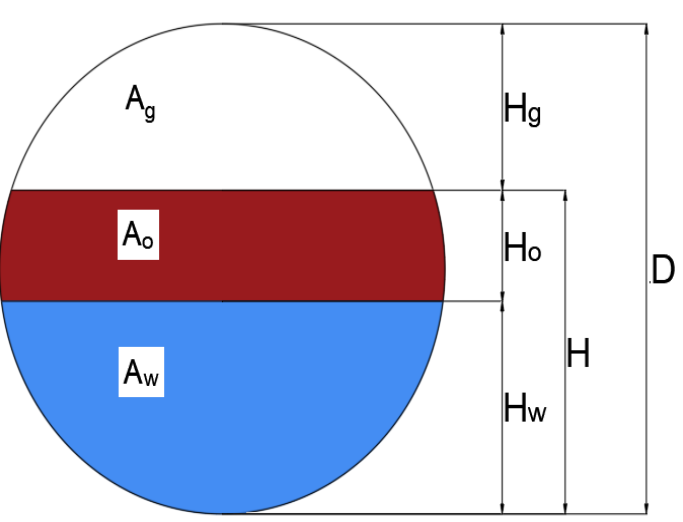
Figure 2. Schematic diagram of the axial interface of the horizontal three-phase separator.